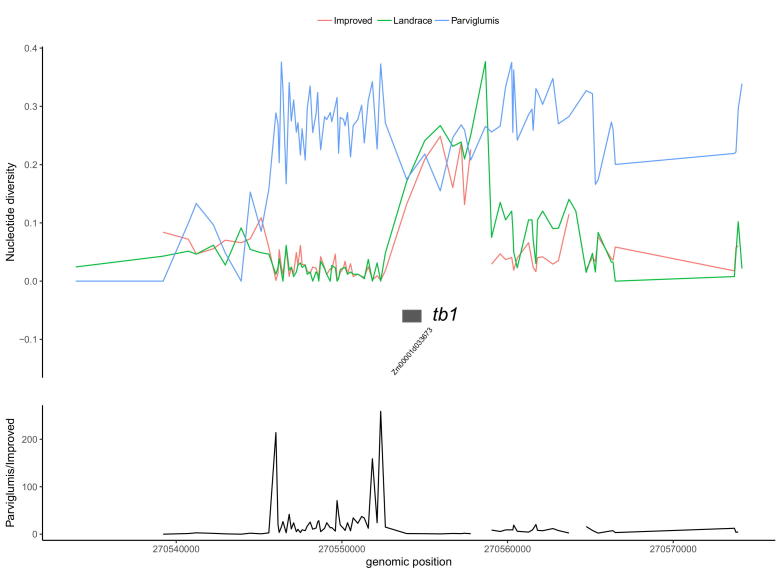
Nucleotide diversity analysis in the genomic region of tb1. The top panel shows the nucleotide diversity of different groups of maize lines. The bottom panel shows the division of nucleotide diversity of teosinte lines by that of the improved maize lines. Improved, improved maize lines. Landrace, maize landrace. Parviglumis, Z. mays ssp. parviglumis (teosinte lines).